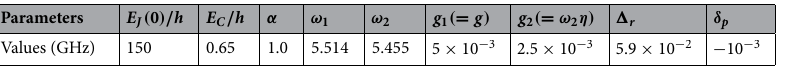
Table 1. Important parameters of the circuit QED with artificial atom presented in unit of GHz. ω p ω r � r ω r ω d and δ p = − = −